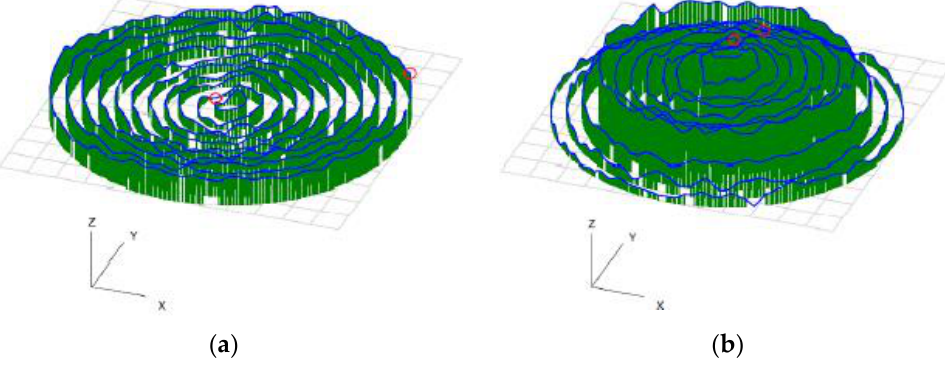
Figure 23. Flatness deviations ( a ) constant step over-pocket auto border; ( b ) spiral strategy. show that the best equality value was obtained for the Circular pocket strategy. Table 6. Flatness deviations for individual parts.